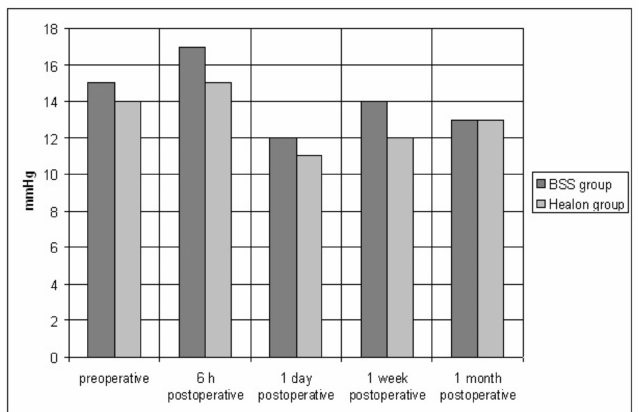
Figure 13. Mean IOP, preoperative and postoperative (6 h, 1 day, 1 week and 1 month). IOP recordings 6 h after surgery, at first postoperative day, 1 week and four weeks after surgery, are shown in Figure 13. There were no statistically significant differences at any time between the two groups (all p >